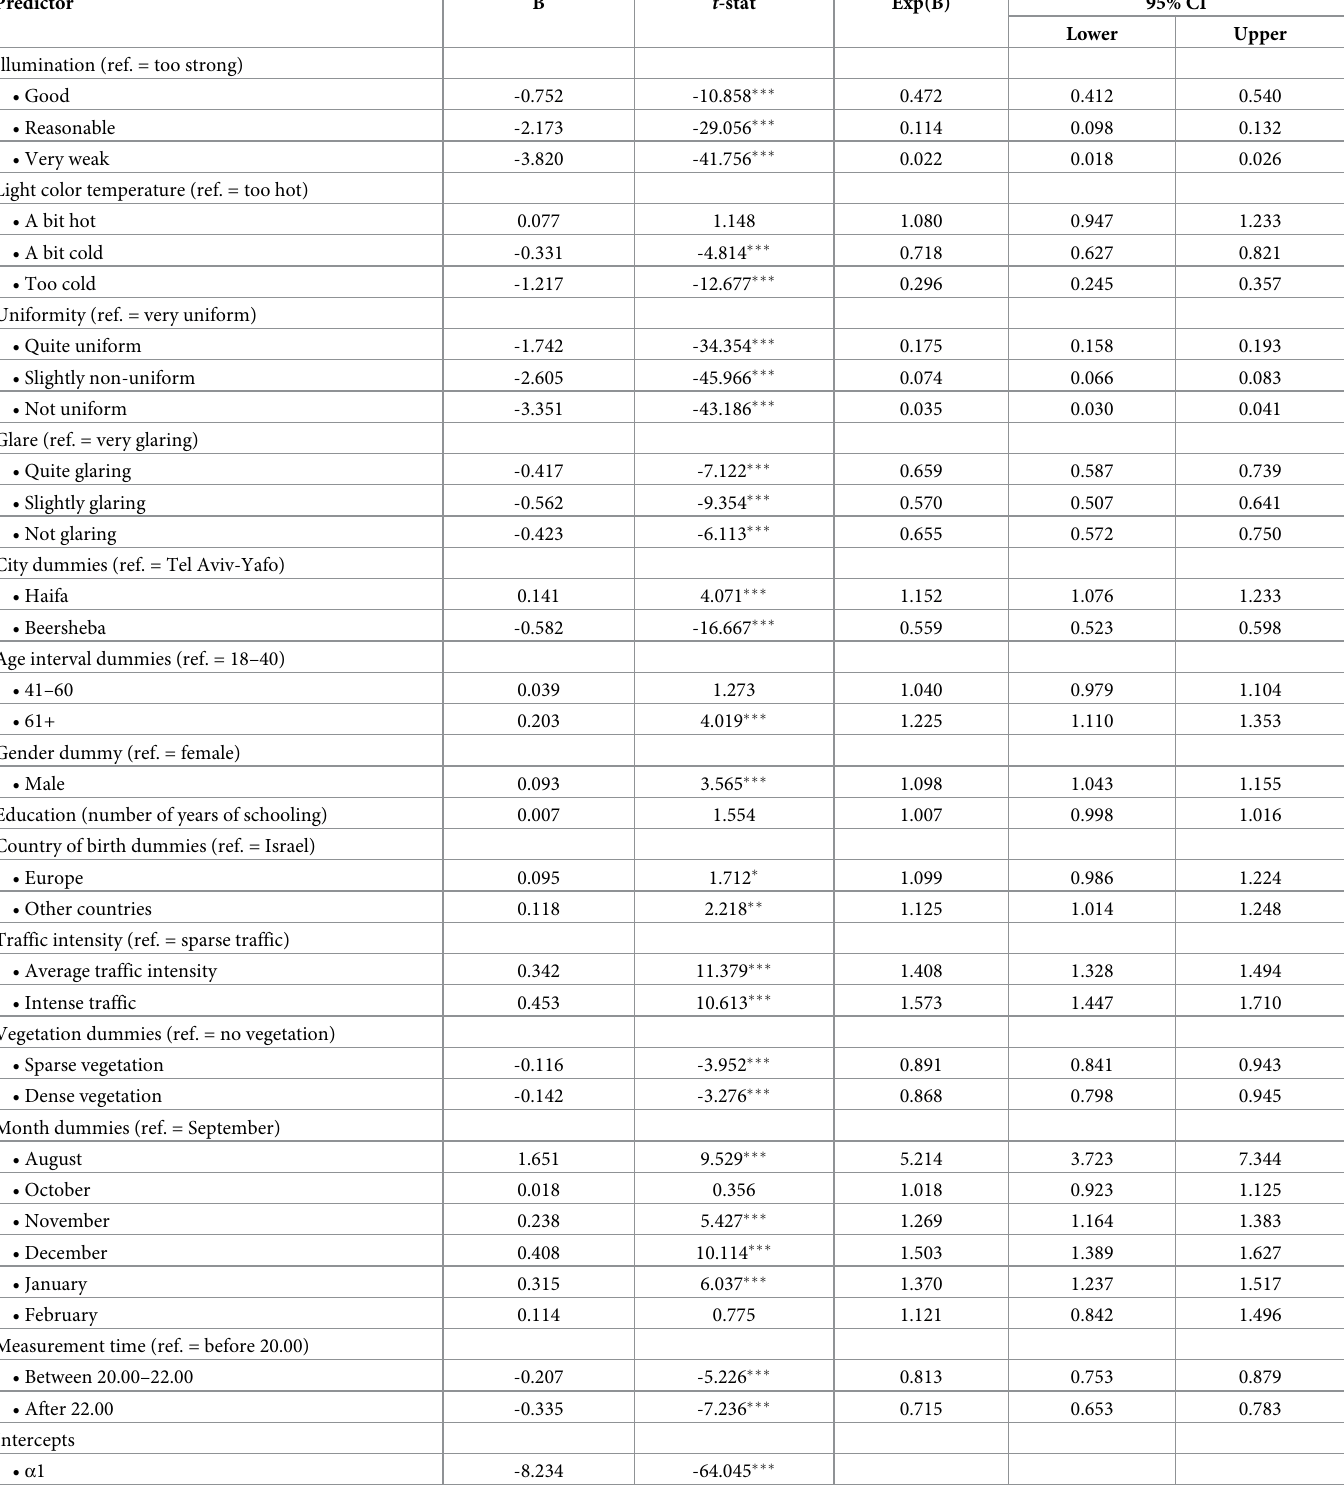
Table 5. Factors affecting FoS in the neighborhoods surveyed (method: Ordinary regression; dependent variable–perception of safety on a 4-point scale from 0 (very unsafe) to 3 (very safe); Model 3: City dummies, social demographic, temporal and locational variables added). Predictor